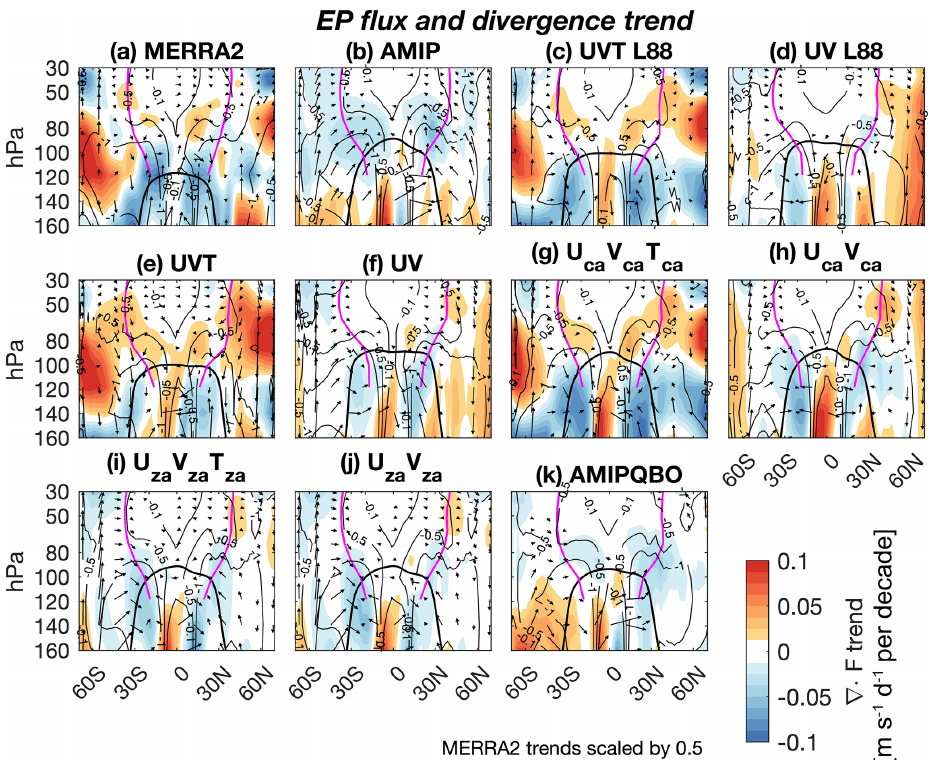
Figure 9. Eliassen–Palm flux (vectors) and divergence (shading) trends, climatological Eliassen–Palm flux divergence (black contours, − 0 . 1, − 0 . 5, and − 1 . 0ms − 1 d − 1 ), and climatological turn-around latitudes for all simulations (magenta). MERRA2 Eliassen–Palm flux and divergence scaled by 0.5. Eliassen–Palm flux vectors have been scaled to appear consistent with the divergence field, to an arbitrary maximum scale consistent across panels (Edmon et al., 1980). Tropopause indicated by the thick black